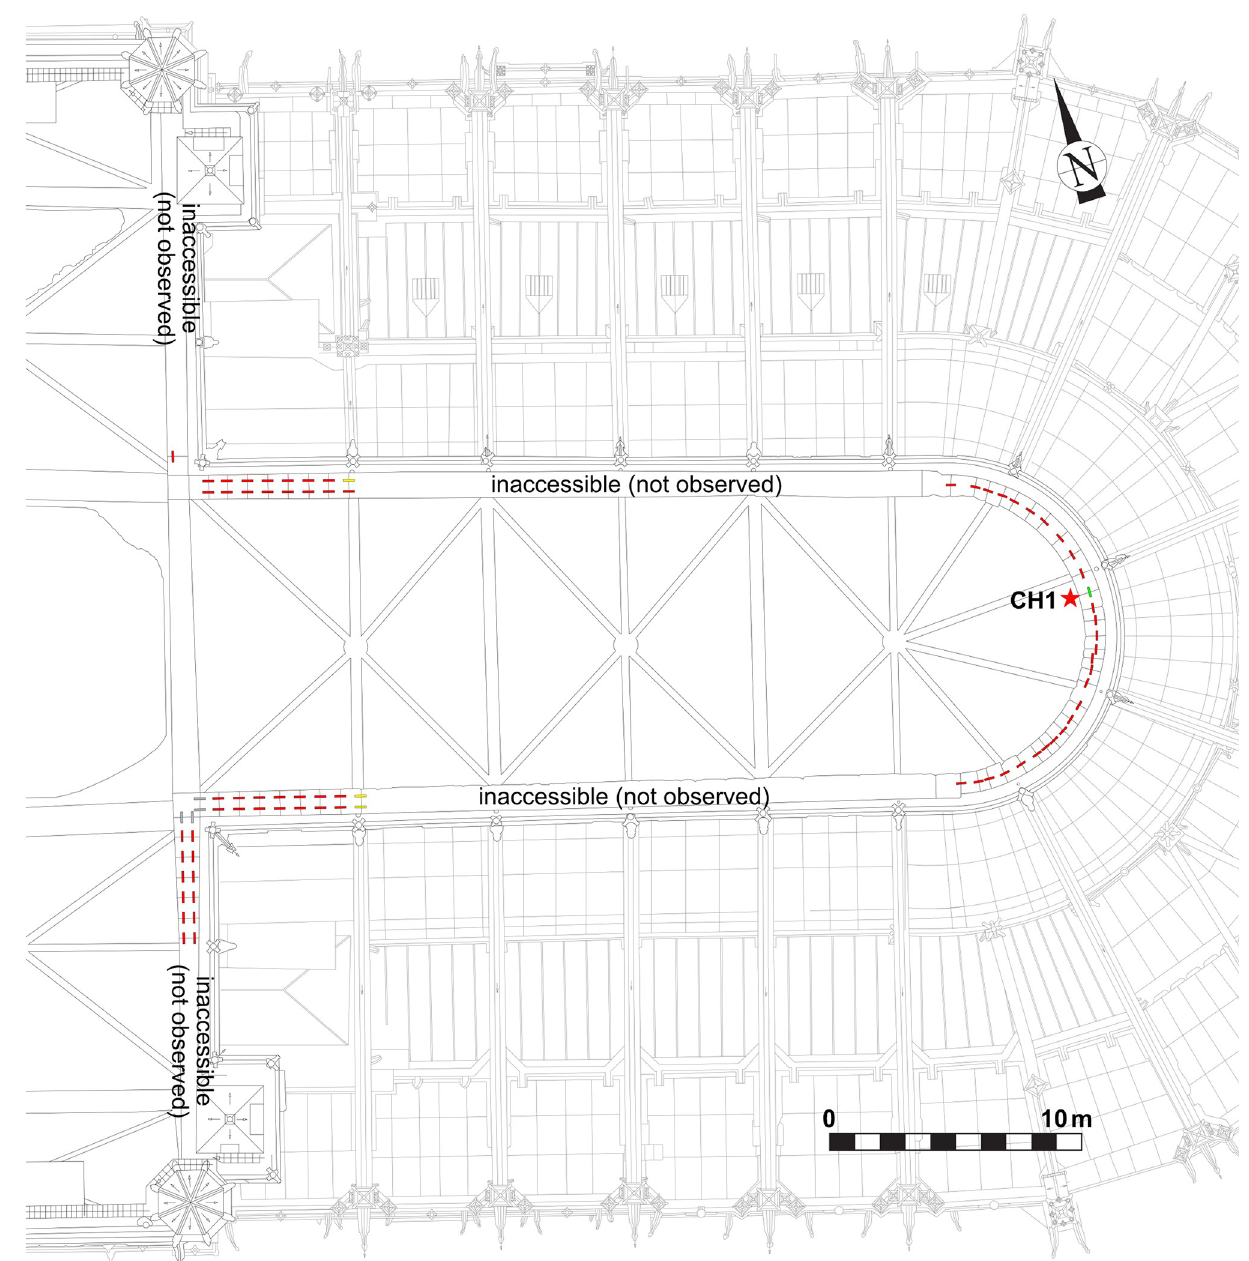
Fig 5. Map of the upper walls in the choir, showing the location of the staples and the sampling (Red = staples observed, Yellow, staples not measured (below provisional roof beams), blue = staples that fell with the fire, Green = staples sampled, Grey = staples formerly removed). Red stars: sampling